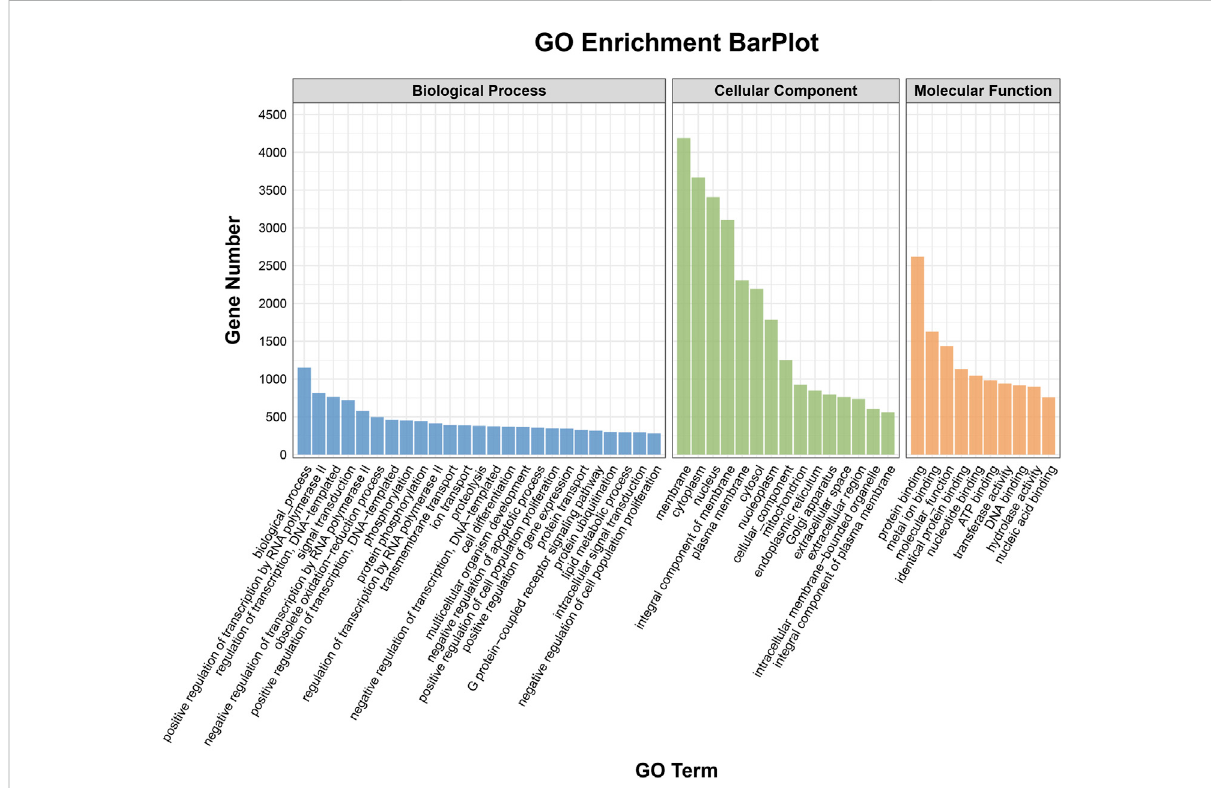
FIGURE 8 GO annotation enrichment analysis of genes encoding miRNAs expressed differentially between the Force-Exo and Control-Exo groups. Blue represents biological processes, green represents cellular components, and orange represents molecular functions.